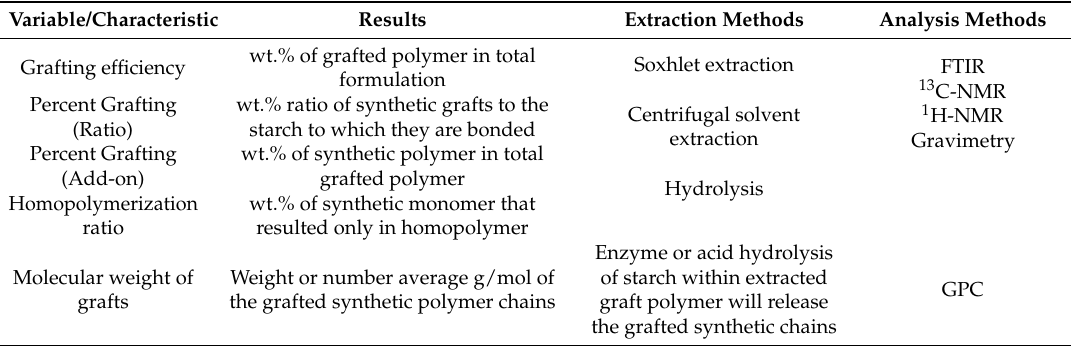
Table 2. Summary of measurements for grafting